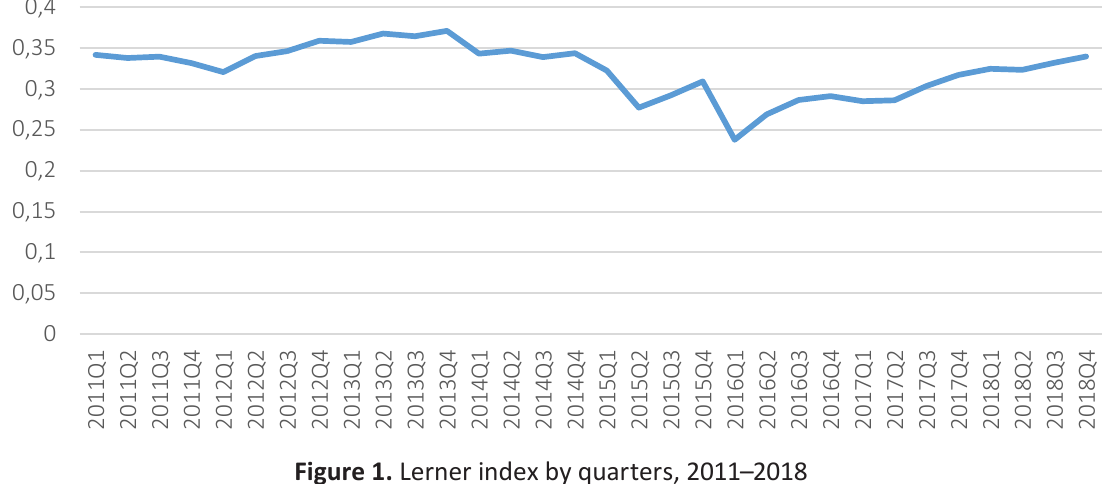
Figure 1. Lerner index by quarters, 2011–2018